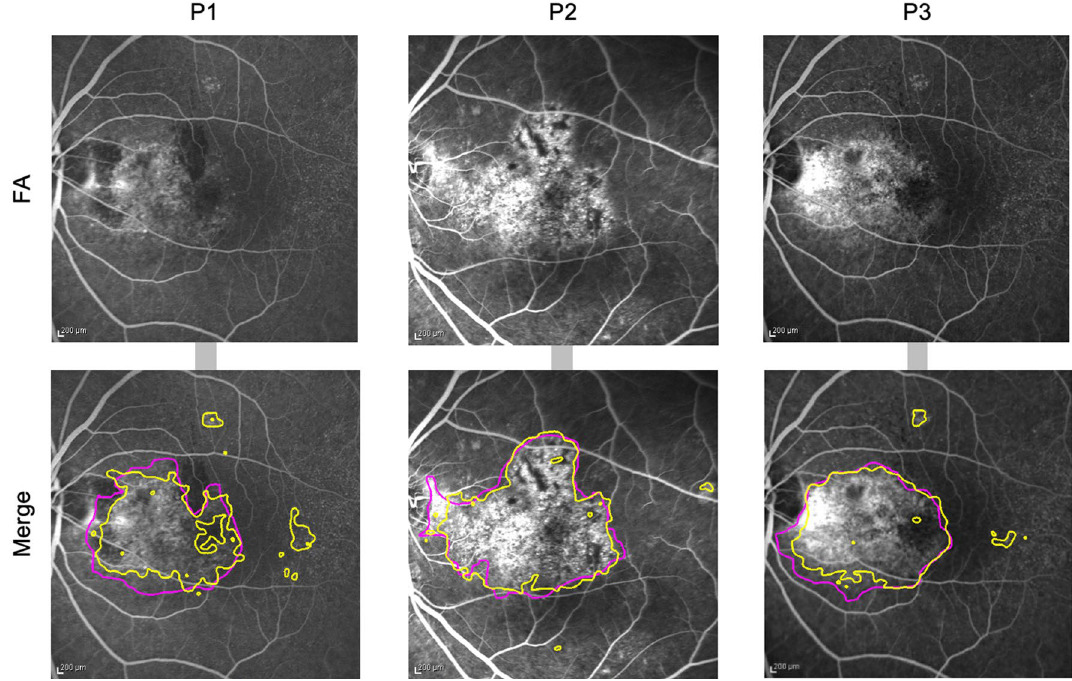
Figure 2. Extraction of abnormal regions from FA images using U-net. Three representative outputs of the processes are based on deep learning (U-net) to detect Abnormal regions (Mask regions) from fluorescein fundus angiography. These images were taken from three different patients (P1-3). Upper: Original raw FA images. Lower: annotated/predicted images. Purple frames represent Abnormal regions annotated by ophthalmologists, and yellow frames represent Abnormal regions predicted by